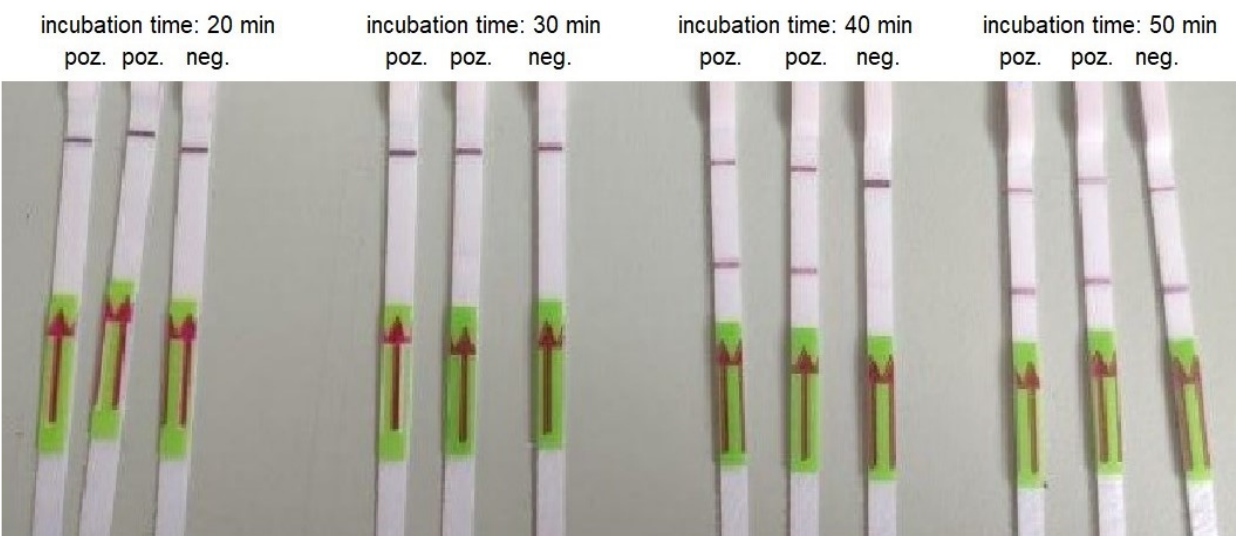
* weak reaction is shown in brackets.